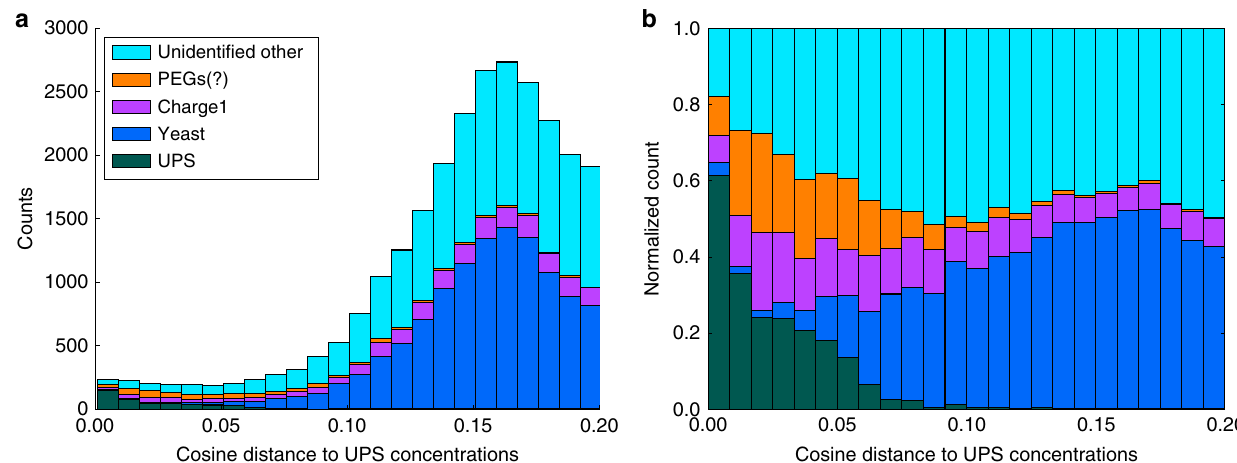
Fig. 2 The number of feature groups and their origin as a function of dissimilarity to the UPS1 spike-in concentrations. The histograms display the number ( a ) and relative number ( b ) of feature groups as a function of the cosine distance relative to the UPS1 spike-in concentrations using the cascaded search of Tide followed by MODa. The vast majority of the identi fi ed feature groups had an abundance pattern that conformed to their origin. Still, a large proportion of feature groups remained unidenti fi ed, including a group that was tentatively identi fi ed as polyethylene glycols (PEGs), which exhibited an abundance pattern similar to the UPS1 proteins. The cosine distance between the yeast and UPS concentrations was 0.16 and we can indeed observe that the majority of the yeast peptides center around that value.